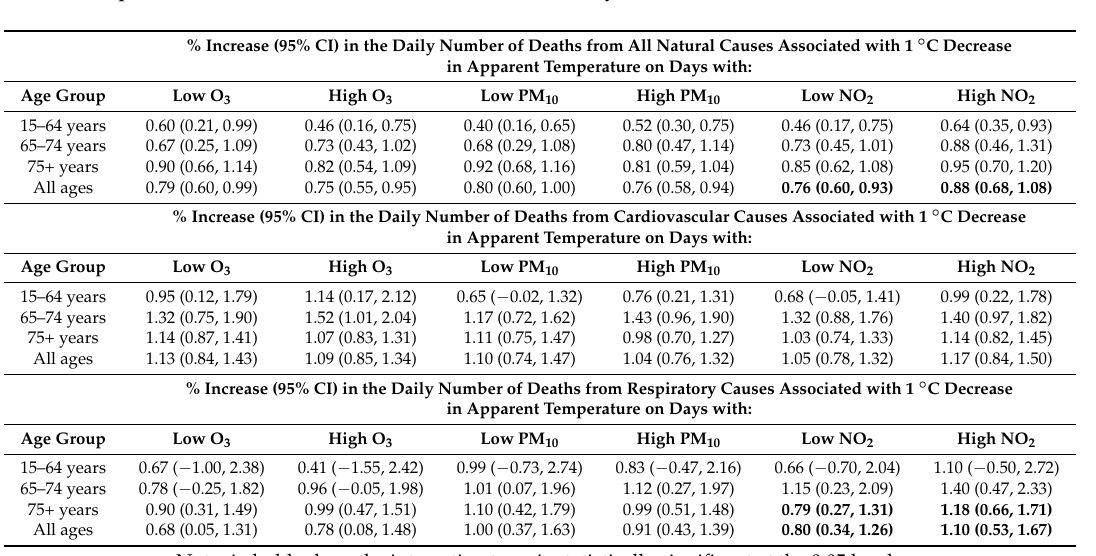
Table 5. Pooled (from nine city-specific estimates) percentage increase (95% CI) in the daily number of deaths per degree Celsius decrease in apparent temperature in the cold period in days with “low” (at the 25th percentile of each city-specific distribution) or “high” (at the corresponding 75th percentile) level of pollutant. Results from random effects